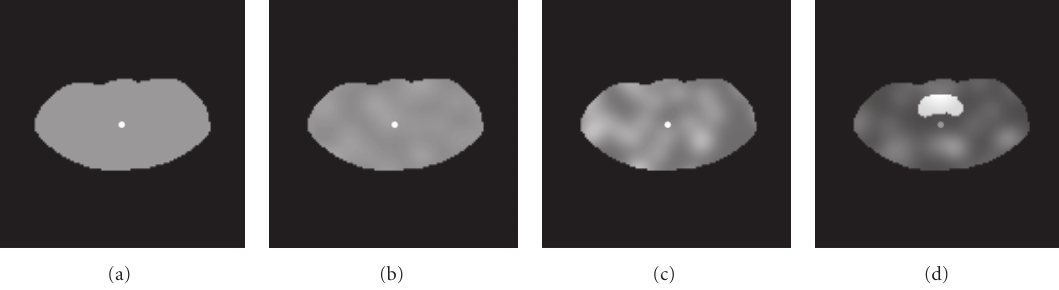
Figure 3: The simulated phantom with the 15-mm lesion in four di ff erent backgrounds. (a) The uniform background; (b) a lumpy back- ground of b = 0 . 02 and σ = 32 mm; (c) a lumpy background of b = 0 . 1 and σ = 23mm; and (d) a lumpy background of b = 0 . 1 and σ = 23 mm with a hot region mimicking bladder uptake. The mean of the background in all cases is about 0 .